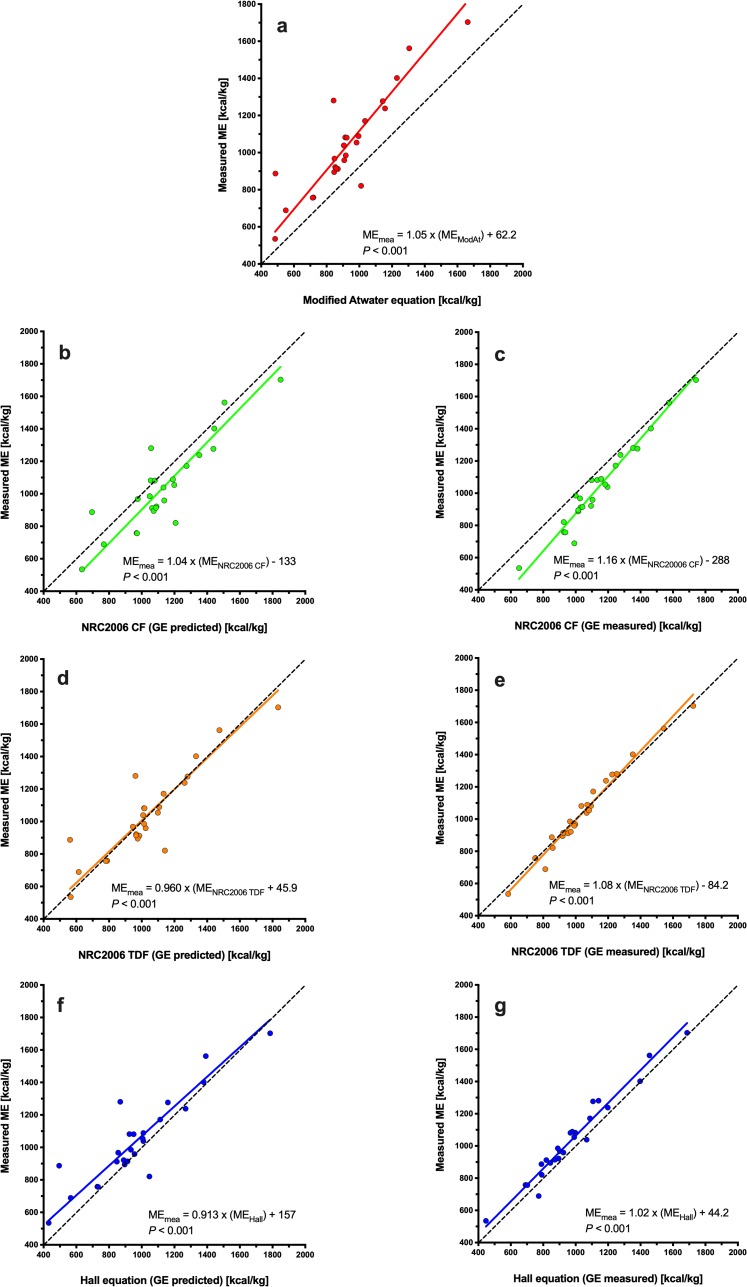
Deming regression plot depicting the relationship between measured and predicted metabolisable energy (ME) content in wet canine diets.The points represent results for individual foods, the solid line depicts the trendline from Deming regression, and the dotted black line represents the line of equivalence (where each unit increase in predicted ME equates to the same increase in measured ME. Different figures represent predictions made with MA (red, a), NRC 2006cf (green; b: predicted GE; c: measured GE), NRC 2006tdf (orange; d: predicted GE; e: measured GE), and Hall equations (blue; f: predicted GE; g: measured GE).